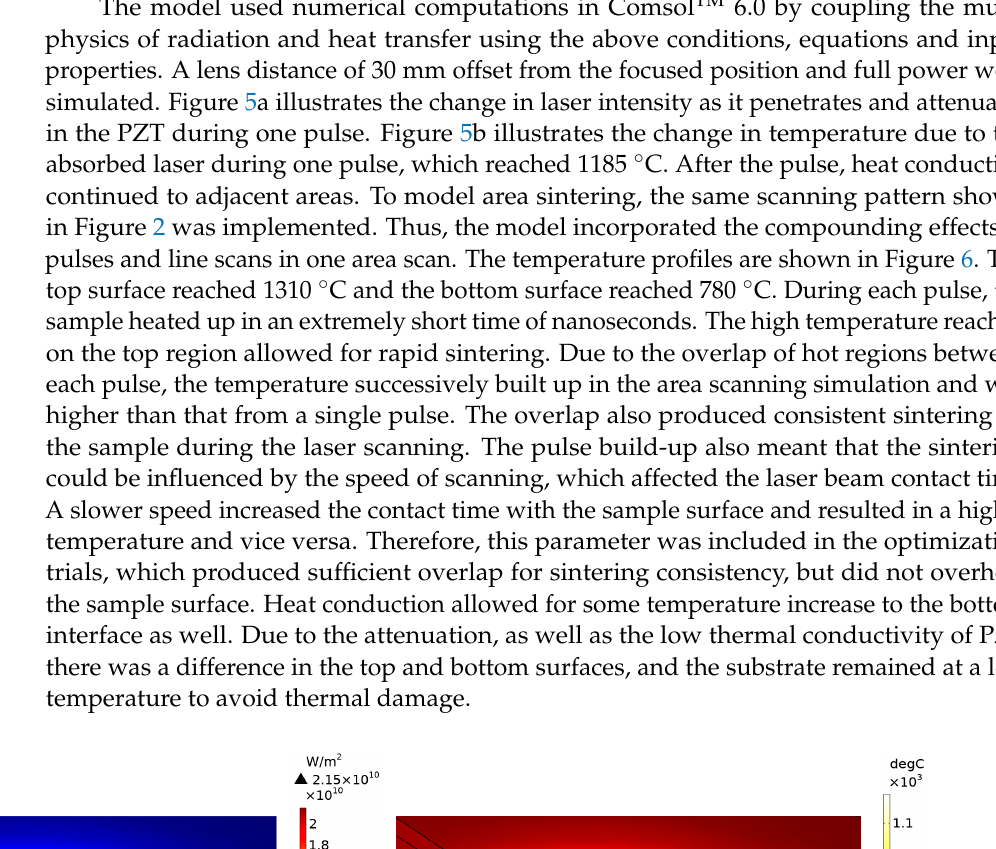
Figure 6. Temperature changes during one area scan. ( a ) Top surface; ( b ) bottom surface. The effects of adding CNTs were also modelled. The material properties of CNTs were found in published sources [52,53]. The rule of mixtures was used to predict the properties of the composite, as shown in Table 4. Table 4. Material properties of CNT/PZT used in the finite element simulation. Property Value (0.5% CNTs)